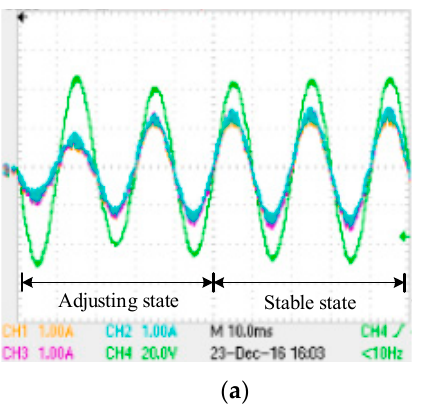
Figure 20. The output current waves of the three parallel traction substations and the load voltage wave. ( a ) The waves under the adjusting state and stable state; ( b ) the relationship between the current waves and the load voltage wave under the stable state (CH1: the output current of the SS1; CH2: the output current of the SS2; CH3: the output current of the SS3; CH4: the voltage of load.).